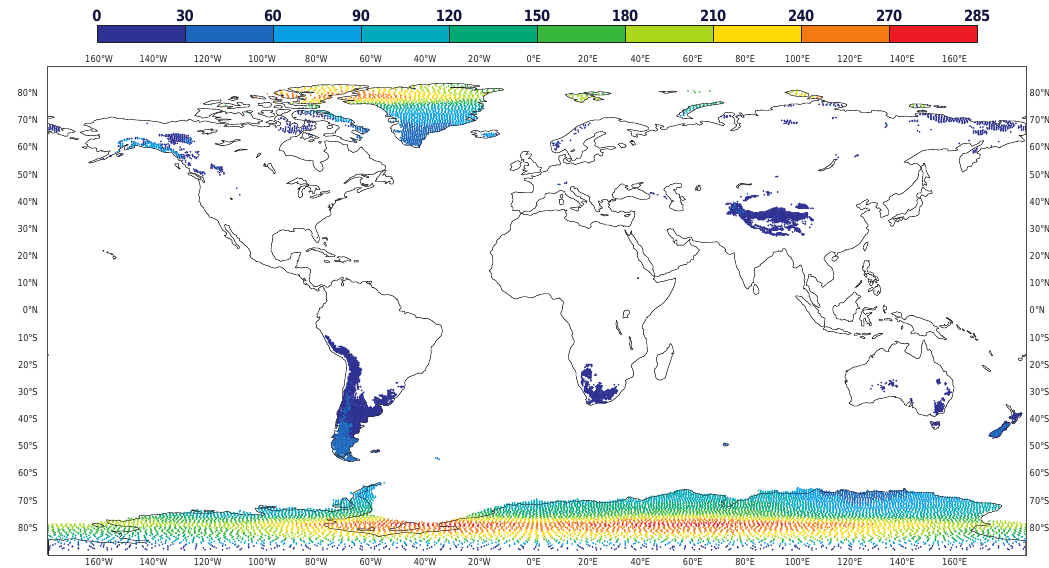
Figure 6. Number of SMOS observations in snow-covered or frozen soils, from 1 to 15 July 2012. Values are shown per model grid cell.